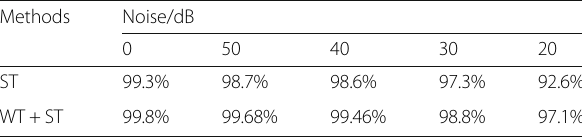
Table 2 Comparison of recognition results of different feature extraction methods